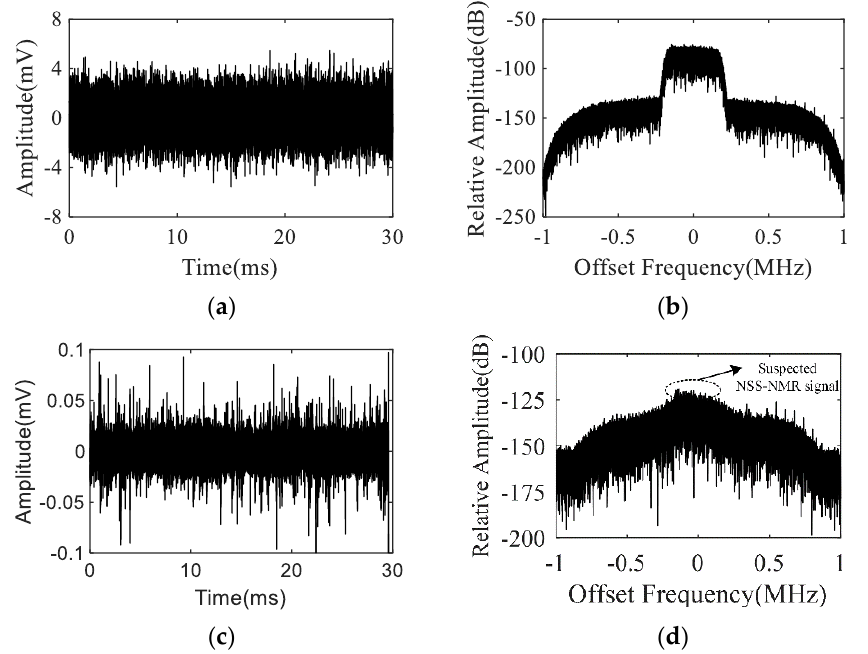
Figure 14. Results of: ( a ) The waveform of the original probe output signal. ( b ) The power spectrum of the original probe output signal. ( c ) The waveform of the probe output signal after interference cancellation by adaptive filtering. ( d ) The power spectrum of the probe output signal after interference cancellation.